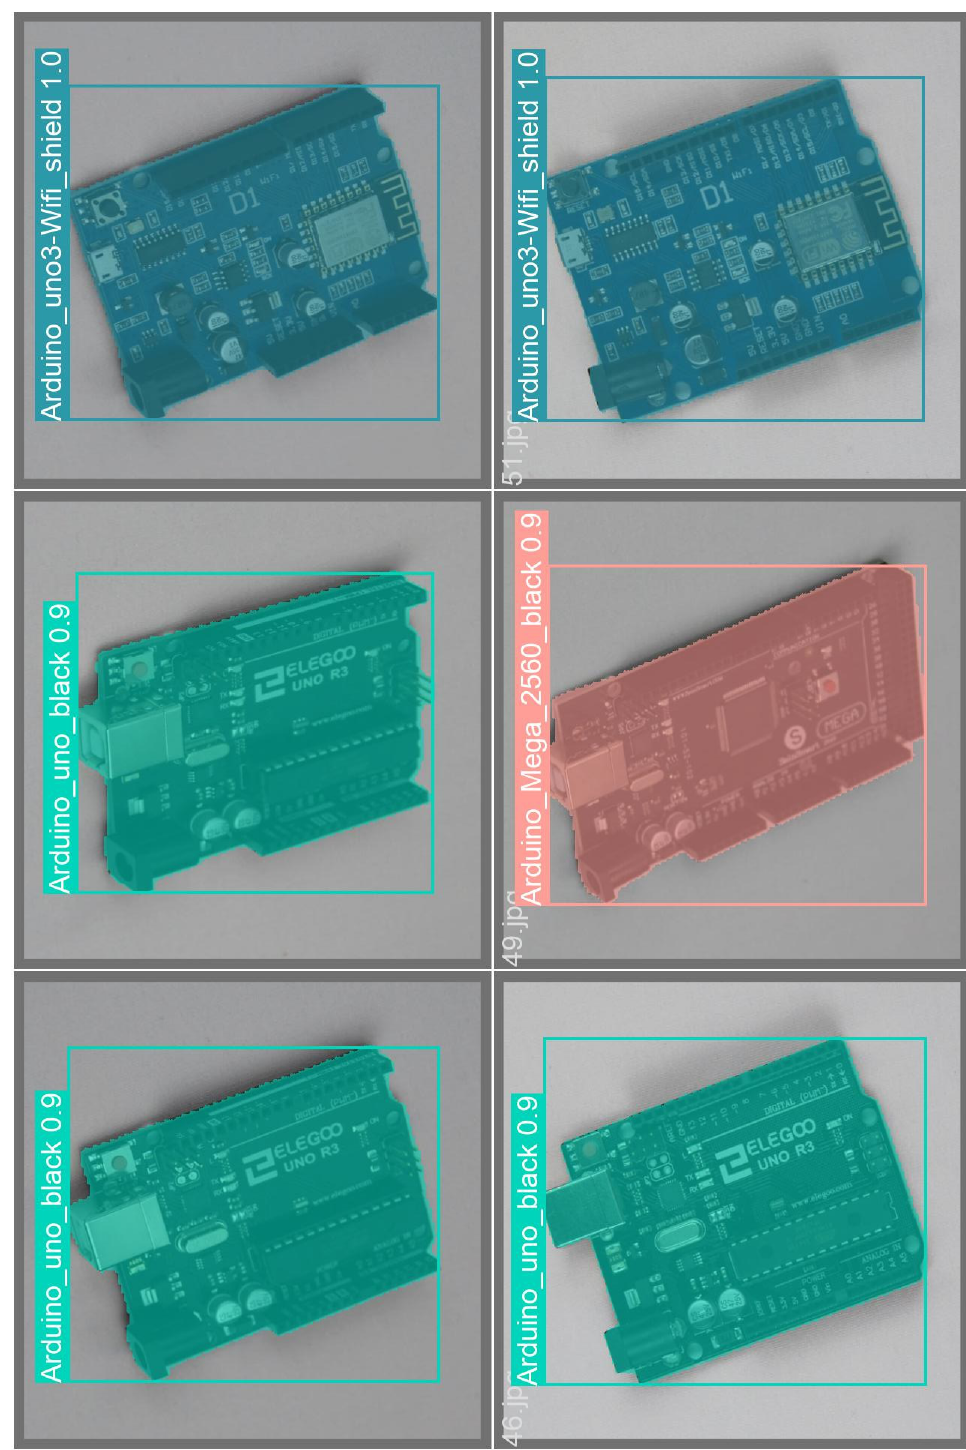
Figure A2. Intended classes of the first